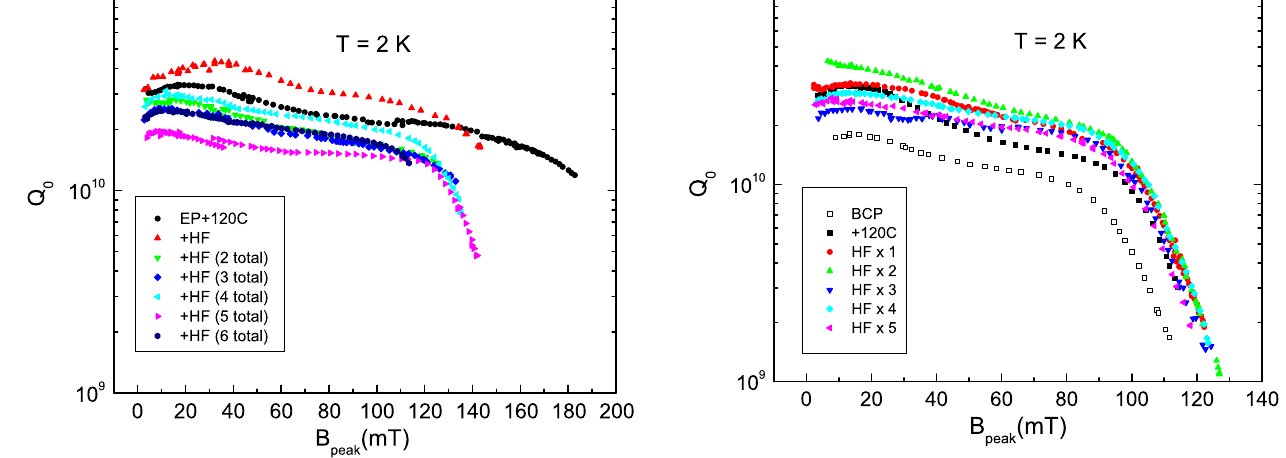
FIG. 2. Cavity rf test results after multiple HF rinse cycles for the electropolished tumbled cavity TE1ACC002.